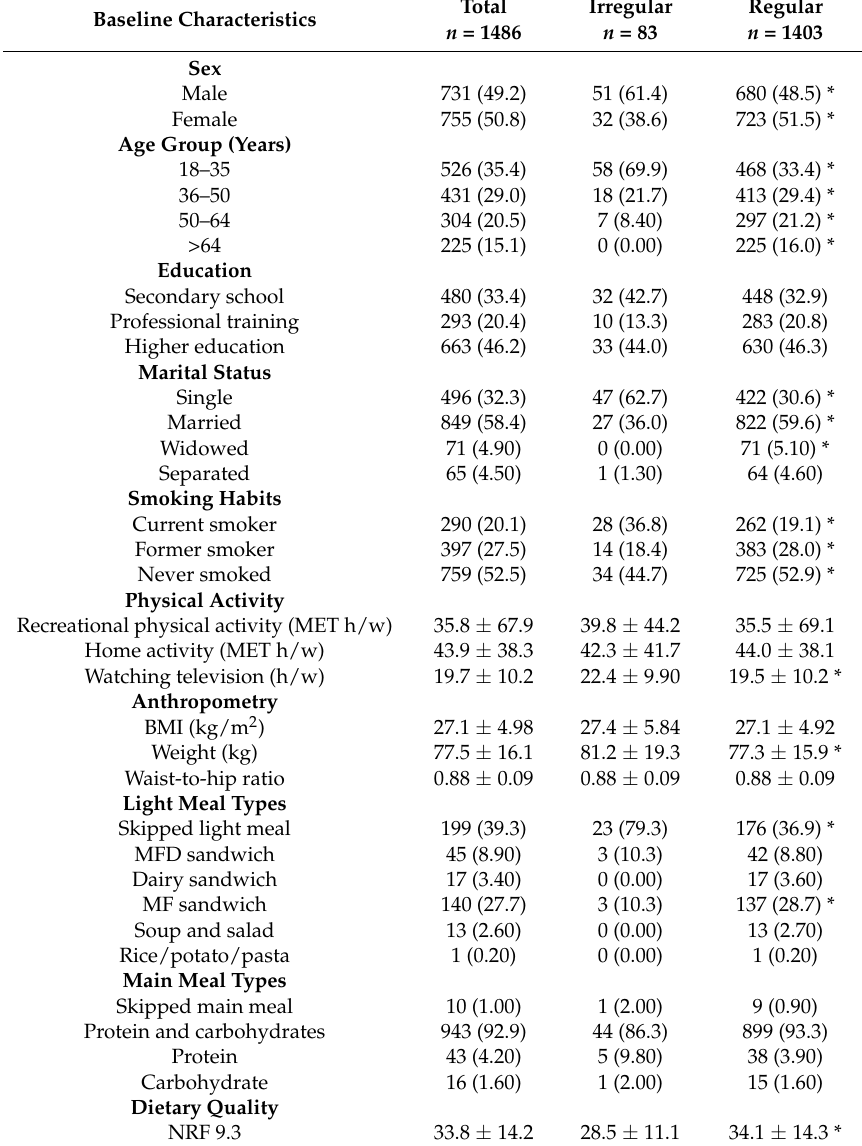
Table 1. Demographic and lifestyle characteristics of regular and irregular breakfast consumers, from a 4-day national dietary survey of Irish adults ( n =